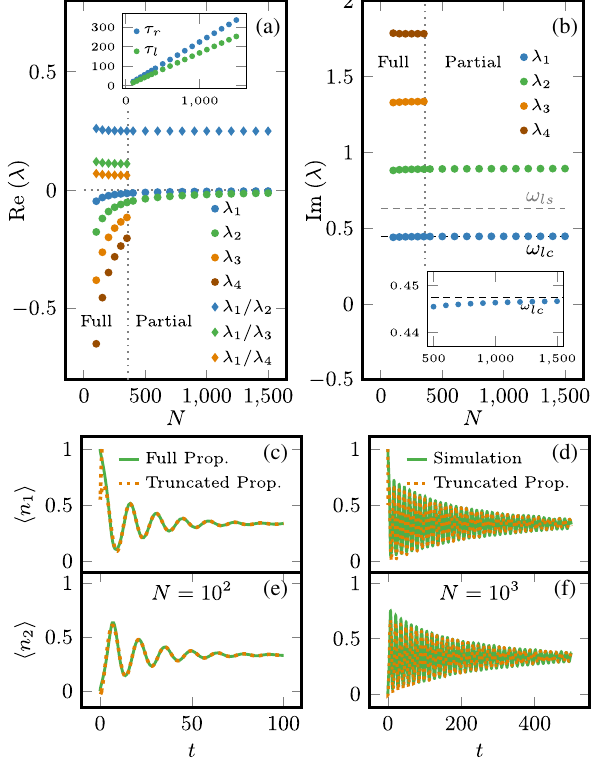
that is lc FIG. 6. Real (a) and corresponding imaginary (b) parts of the four most dominant eigenvalues with a distinct and finite real part for different N and for β ¼ 4 as a representative of the SM phase. The data points corresponding to system sizes larger than N ¼ 350 do not result from a full diagonalization of the matrix but are obtained by exploiting the sparseness of the matrices (maximal six of the approximately N 2 = 2 entries of every row or column are nonzero), using a recursive algorithm, to obtain the dominant part of the spectrum. The inset depicts the relaxation timescale τ and the lifetime of the metastable state τ as a r l function of N . In (b), the dashed, horizontal lines labeled as ω lc and ω correspond to the LC frequency in the MF and to the ls imaginary part of the linear stability matrix eigenvalue from Eq. (24), respectively. The mean occupation density h n as a i i function of time for both the full [Eq. (25b)] and truncated [Eq. (28)] propagation [ i ¼ 1 in (c),(d) and i ¼ 2 in (e),(f)] for the different network sizes N ¼ 10 2 and 10 3 . The dynamics for N ¼ 10 3 is generated using the direct Gillespie method.